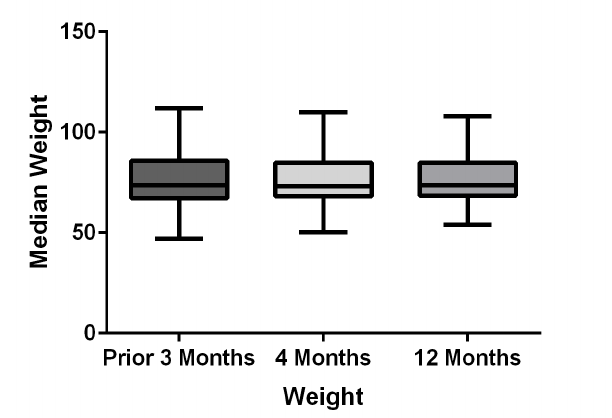
Figure 3: Median weight and duration of CSII